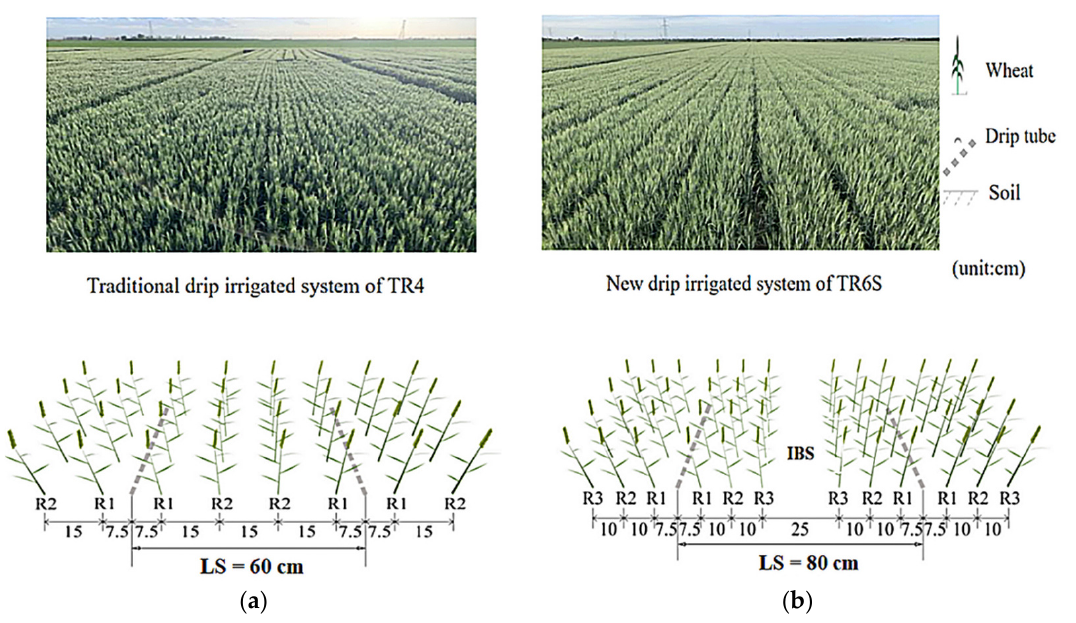
Figure 1. Planting patterns and anthesis canopy picture of wheat under the traditional (TR4) and new (TR6S) drip-irrigated systems. ( a ) TR4: one tube serves four rows of wheat plants with a standard row spacing of 15 cm. ( b ) TR6S: one tube serves six rows of wheat plants with a row spacing of 10 cm and an inter-block spacing of 25 cm. LS: lateral spacing of different drip-irrigated patterns.